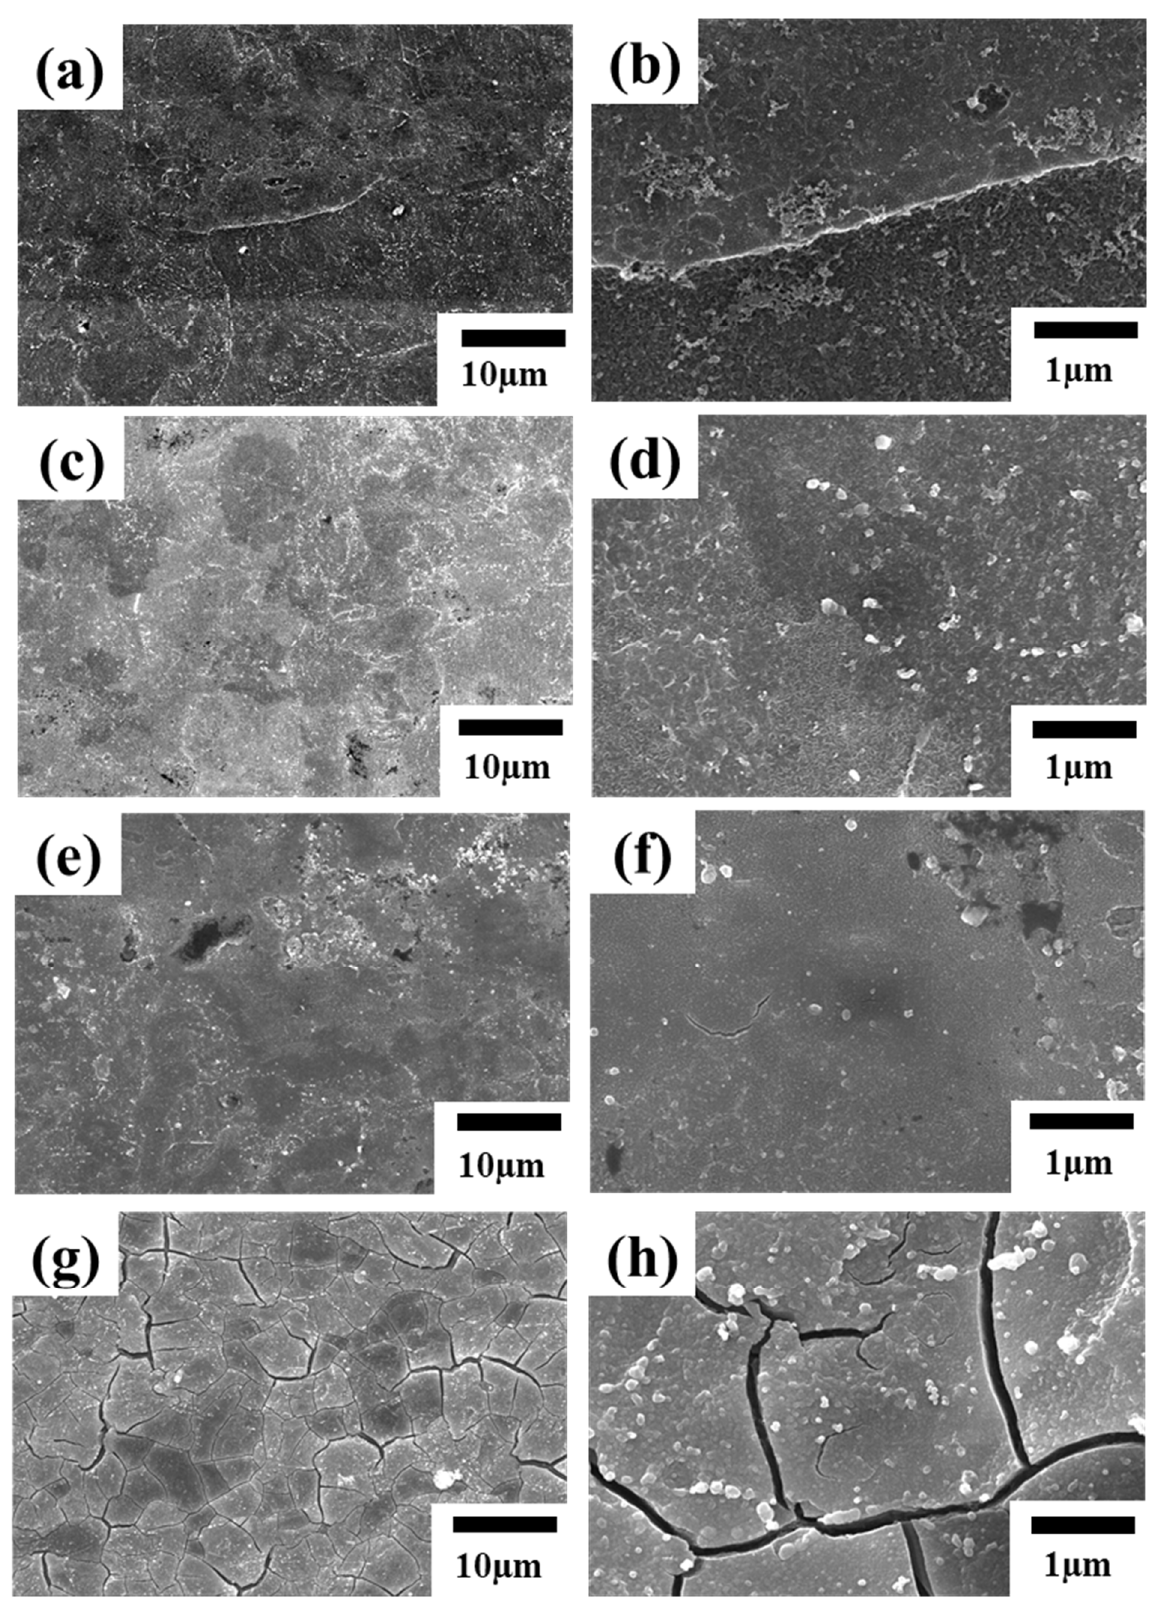
Figure 6. Surface morphology of LZ91 Mg alloy after conversion coating treatment for ( a , b ) 1 s, ( c , d ) 5 s, ( e , f ) 10 s, and ( g , h ) 30 s.